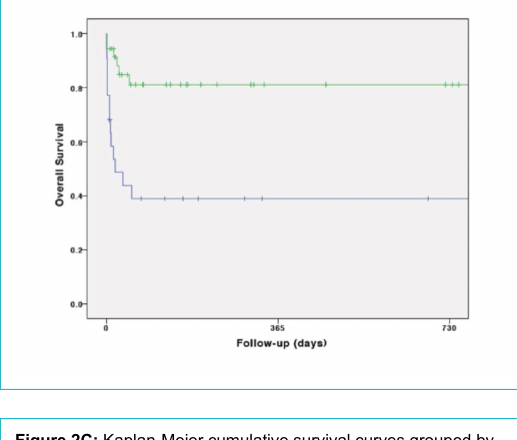
Figure 2C: Kaplan-Meier cumulative survival curves grouped by type of extracorporeal membrane oxygenation (ECMO): green graph veno-venous (VV, n = 35) and blue graph non-veno-venous = veno-arterial (VA, including one patient on veno-venoarterial EC- MO, n = 23). Log-rank (Mantel Cox) test: p = 0.001.